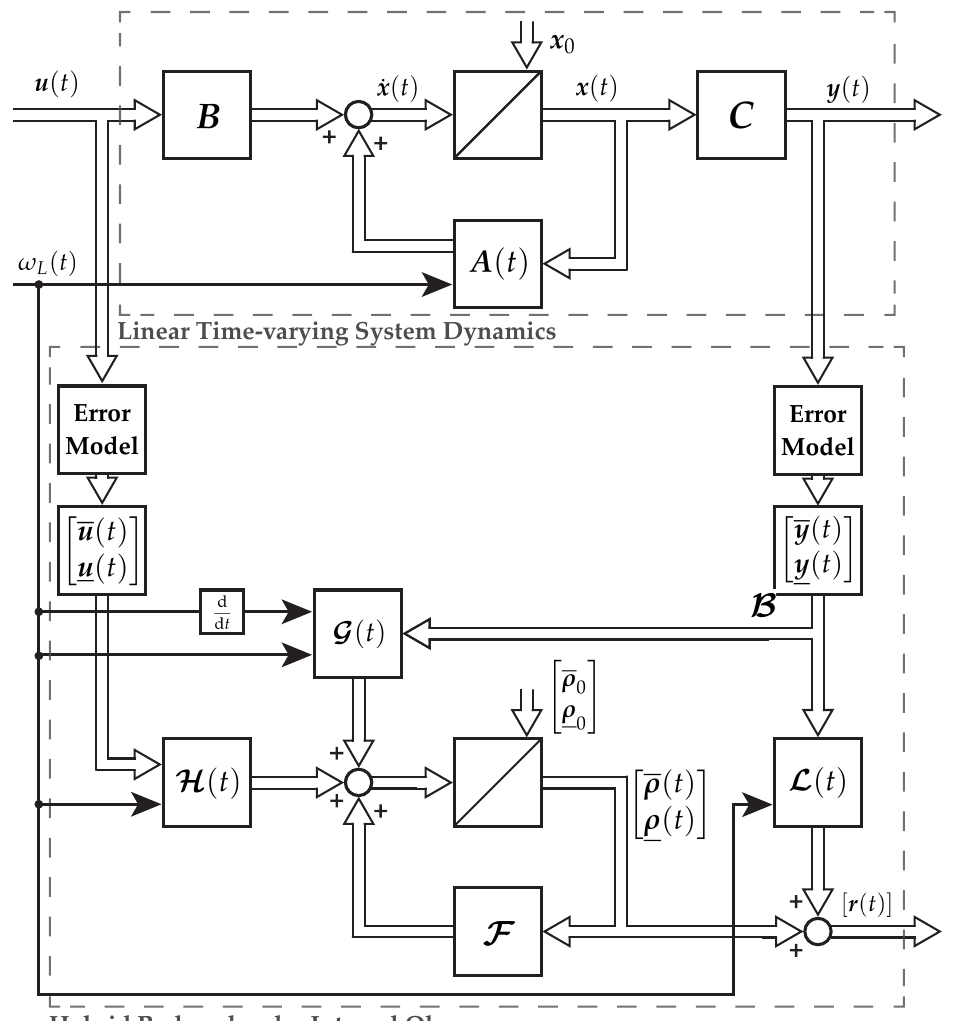
Figure 1. State-space representation and signal-flow of a linear time-varying system as well as the reduced-order hybrid interval observer as a block